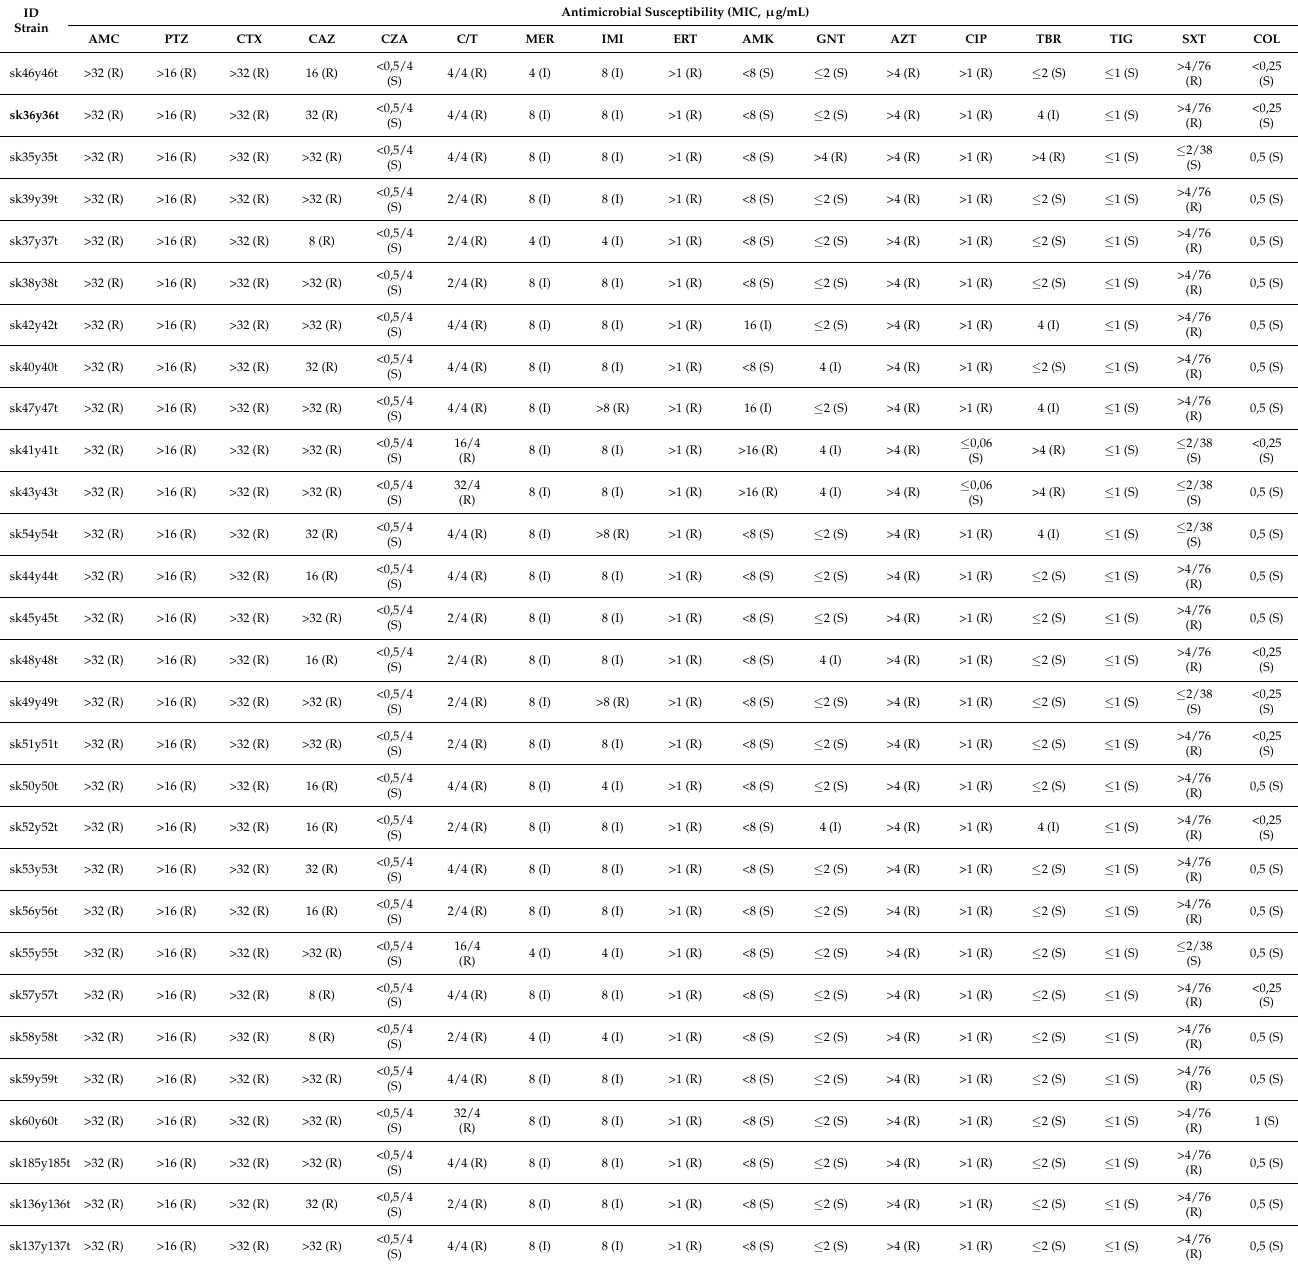
Table 1. Antimicrobial susceptibility profiles of selected KPC-positive E. coli